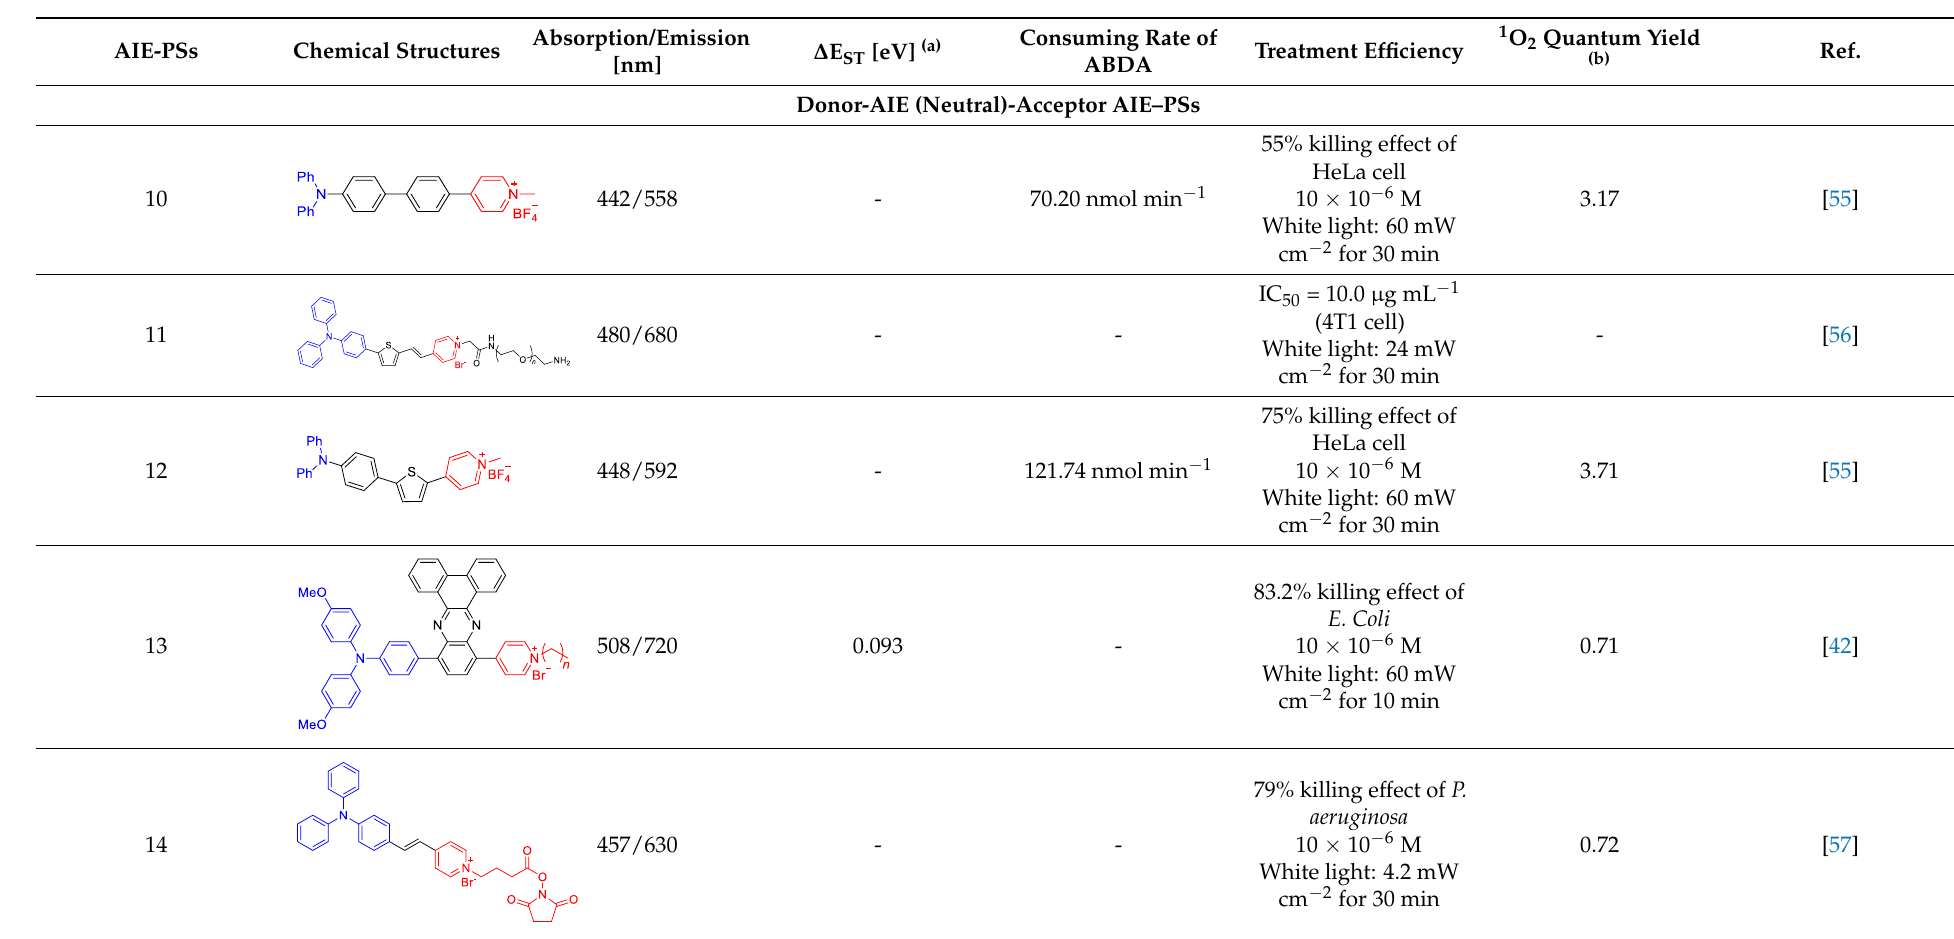
White light: 4.2